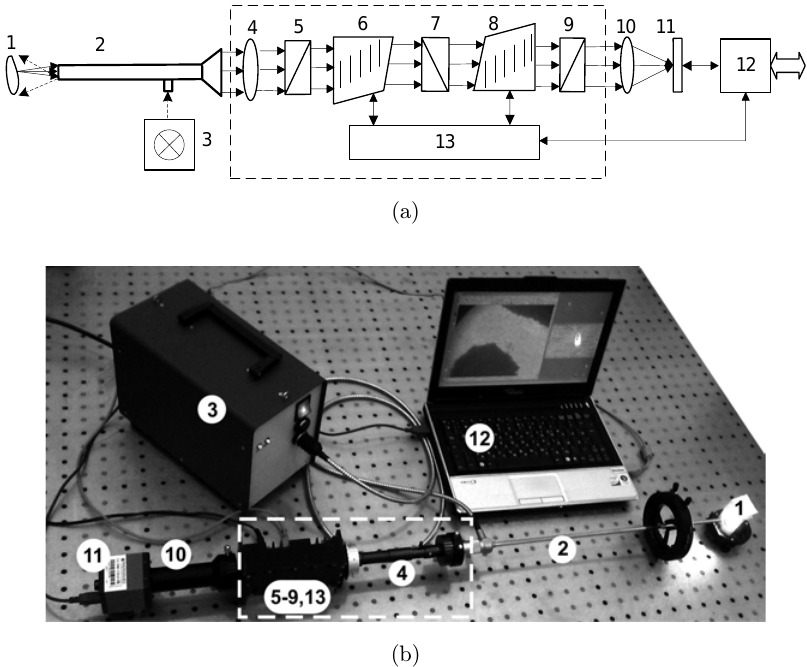
Fig. 3. Optical scheme (a) and appearance (b) of experimental setup. 1 — inspected object; 2 — rigid endoscope probe; 3 — wide- band light source; 4 — optical coupler; 5, 7, 9 — polarizers; 6, 8 — identical wide-angle AO cells; 10 — objective lens; 11 — digital